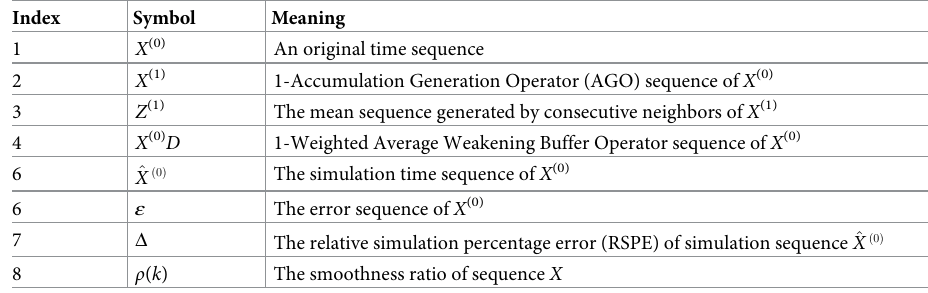
Table 2. Symbols and their meanings[4].